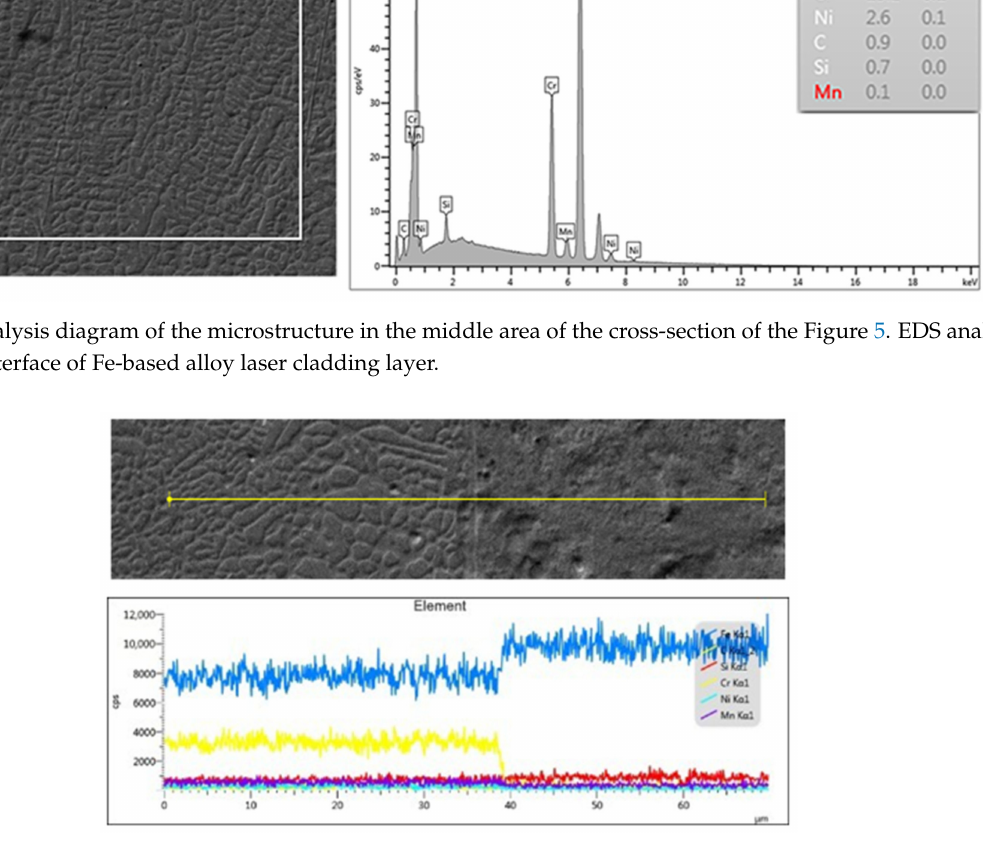
Figure 5. EDS analysis diagram at the interface of Fe-based alloy laser cladding